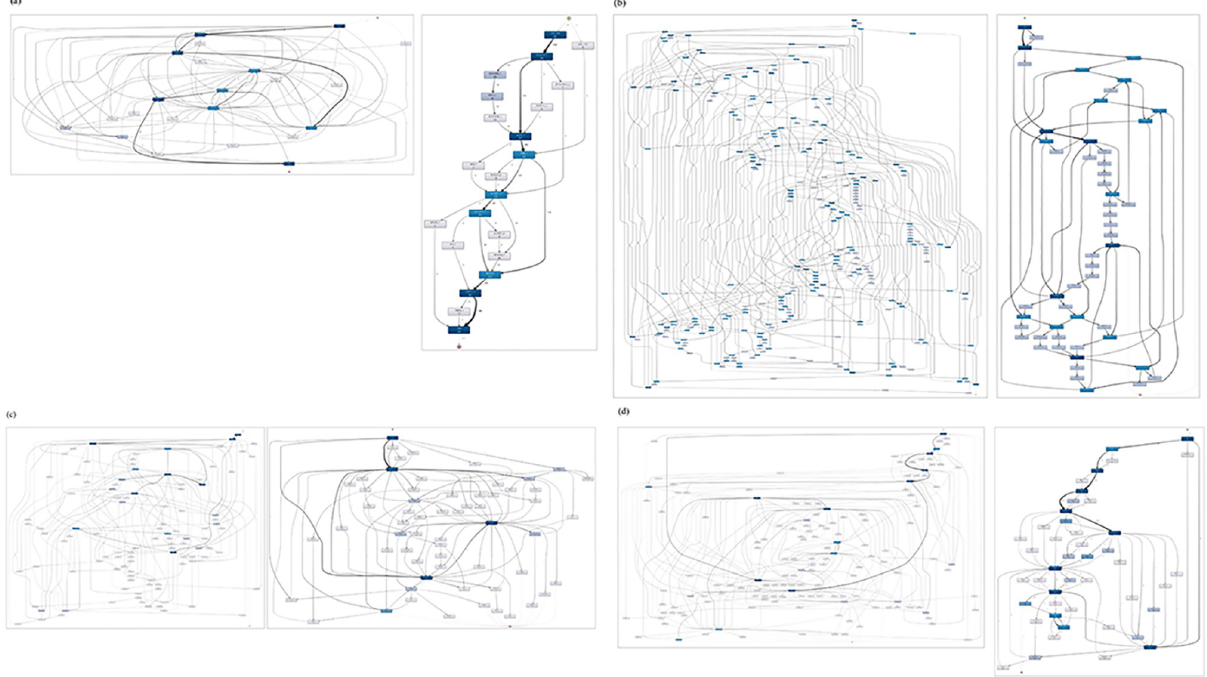
Fig 4. CP discovery for selected surgeries. (From left to right) (a): CP before THR for mainstream behaviors only with all paths, CP before THR with mainstream behaviors and major paths only; (b): CP after CB for death cases, CP for 24 hours after CB for death cases; (c) CP before TAVI, CP for 24 hours after TAVI; (d): CP for 24 hours after PD with all activities, CP for 24 hours after PD with 30%